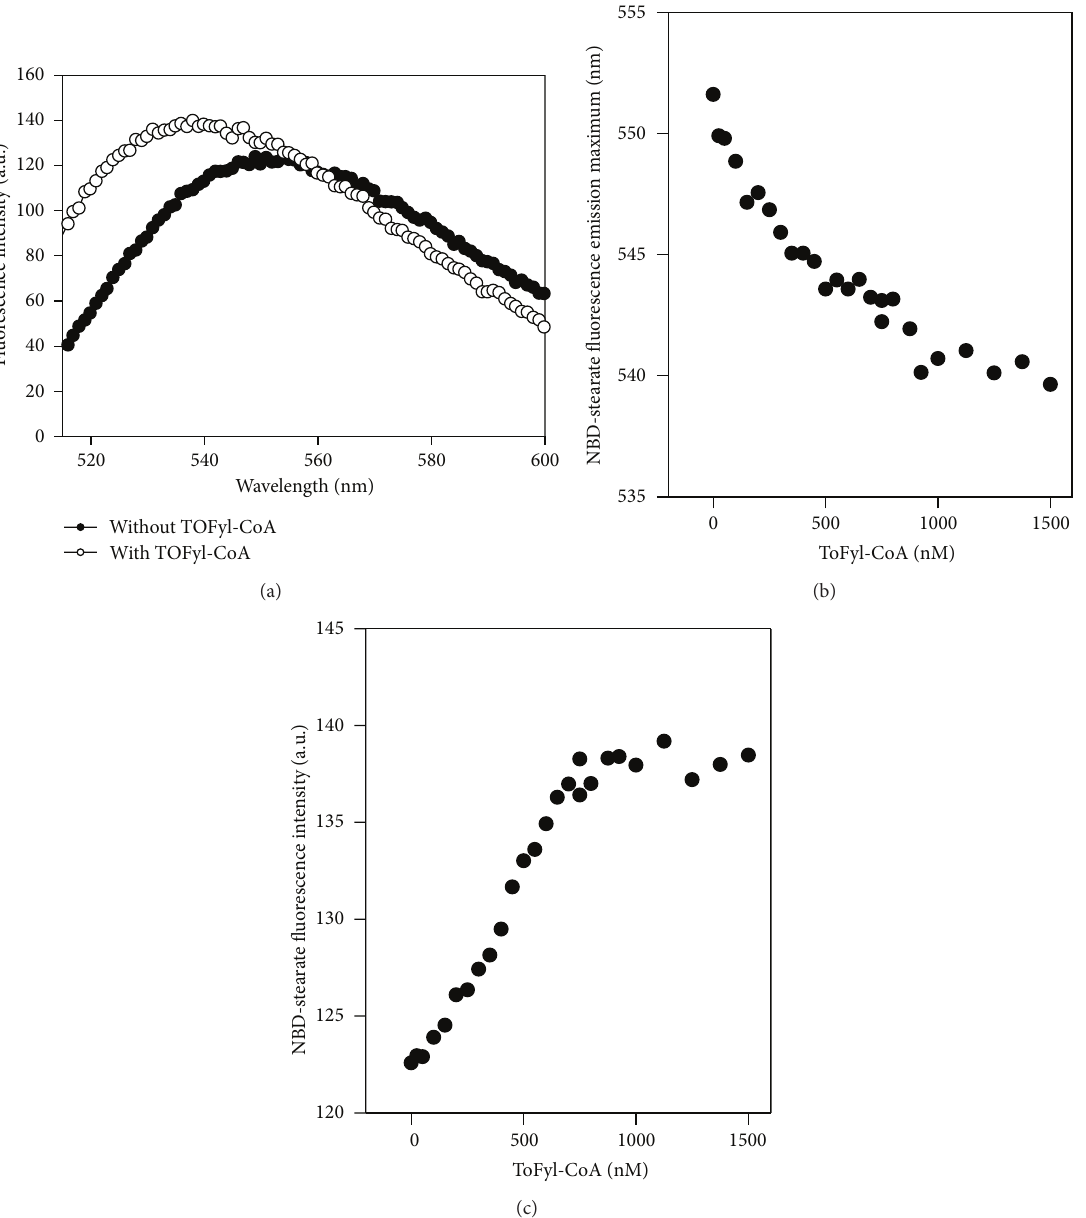
Figure 6: Effect of TOFyl-COA on fluorescence emission characteristics of L-FABP-bound NBD-stearic acid. NBD-stearic acid, bound to L-FABP as in Figure 3, was excited at 490 nm and fluorescence emission spectra obtained before and after addition of TOFyl-CoA (Methods). Panel (a): fluorescence emission spectra of L-FABP- (25nM) bound NBD stearate (80nM) without (filled circles) and with (open circles) of TOFyl-CoA (1500nM). With increasing TOFyl-CoA concentration, the emission maximum of L-FABP-bound NBD stearate shifted to lower wavelength (panel b), and fluorescence intensity increased (panel